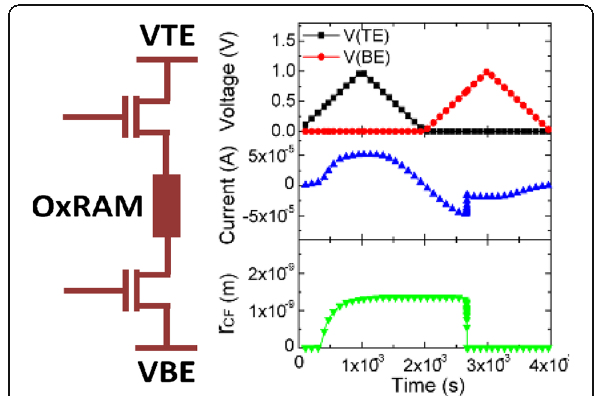
Fig. 13 Simulating the electrical characteristics of the considered 2T-1R OxRAM structure